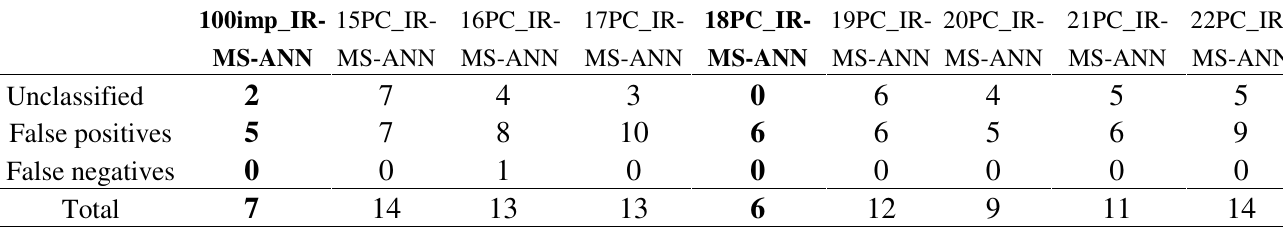
Table 2. The number of unclassified compounds, of false positives and of false negatives obtained by each